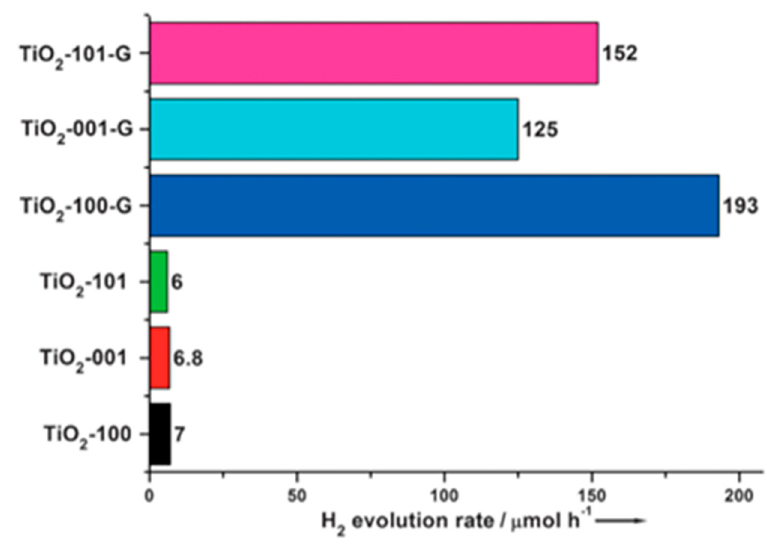
Figure 10. H 2 evolution rates from a methanol solution catalyzed by TiO 2 nanocrystals and TiO 2 - graphene nanocomposites [38]. Reprinted with permission from ref. [38].